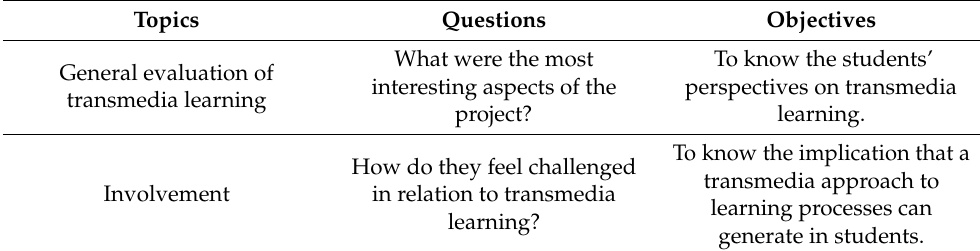
Table 3. Focus groups. Research topics, questions, and objectives. Source: Authors’ creation.